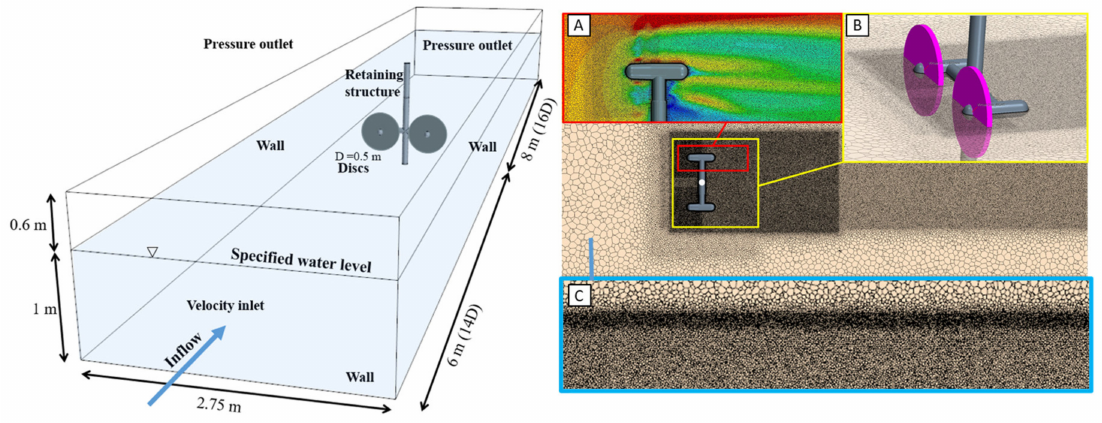
Figure 6. Computational domain with grid refinements: ( A ) near wake, ( B ) blades, and ( C ) free